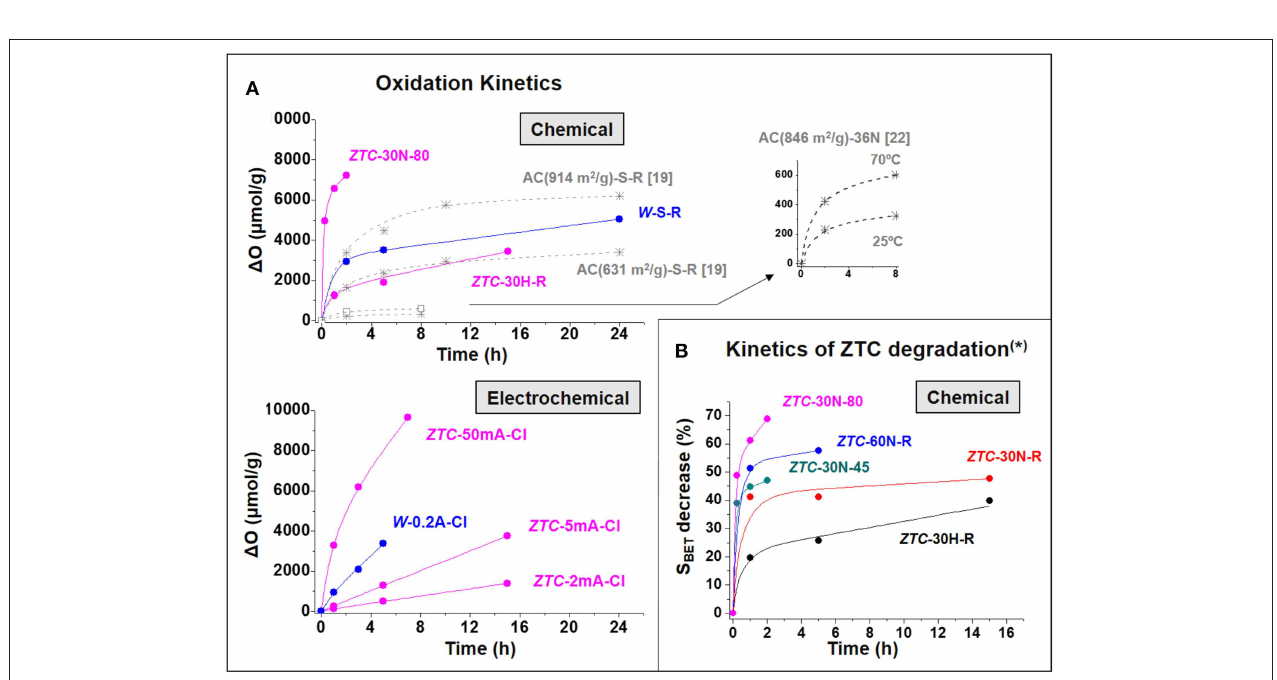
FIGURE 2 | (A) Evolution of the oxidation degree upon time (oxidation kinetics) of various studied and referenced materials functionalized by chemical or electrochemical methods; (B) Evolution upon time of the loss in surface area (associated to structural degradation (*) in section Analysis of Textural Changes) of ZTC functionalized by different chemical